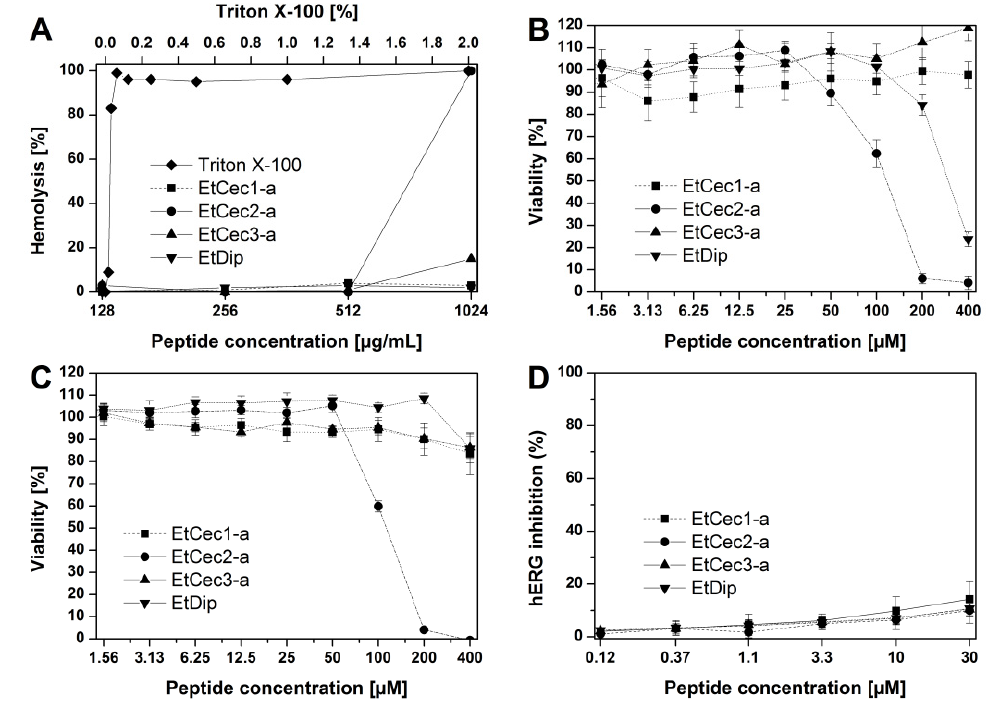
Figure 3. Toxicity of the Eristalis tenax AMPs EtCec1-a, EtCec2-a, EtCec3-a and EtDip. ( A ) Hemolytic activity in the presence of human erythrocytes. ( B ) Cytotoxic e ff ects against HepG2 cells evaluated by neutral red uptake. ( C ) Cytotoxic e ff ects against HepG2 cells evaluated by ATP concentration. ( D ) Cardiotoxic e ff ects against the human ERG potassium channel.